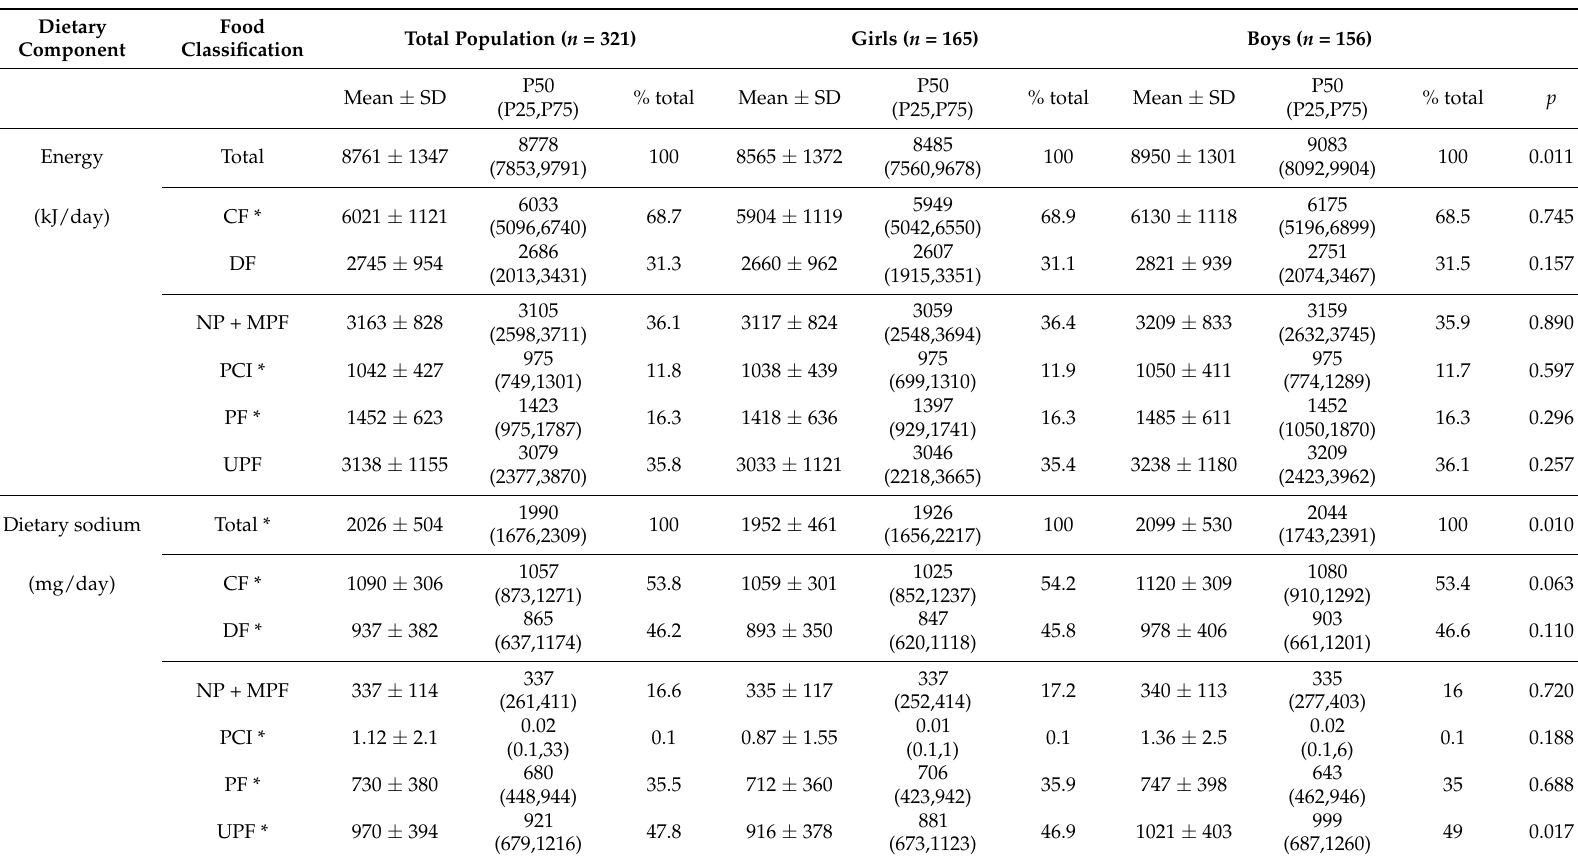
Table 3. Distribution of dietary sodium (mg/day) and energy intake (kJ/day) and contribution to sodium and total energy intake (%) by classifying foods based on the level of processing (NOVA system) or the nutritional profile as core or discretionary